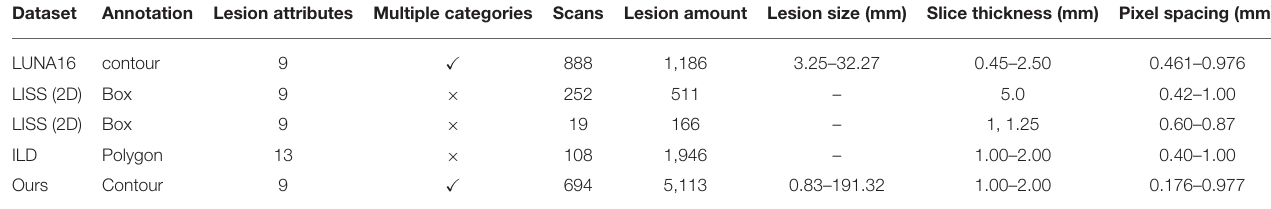
TABLE 1 | The statistical result of comparing our dataset parameters with other datasets.